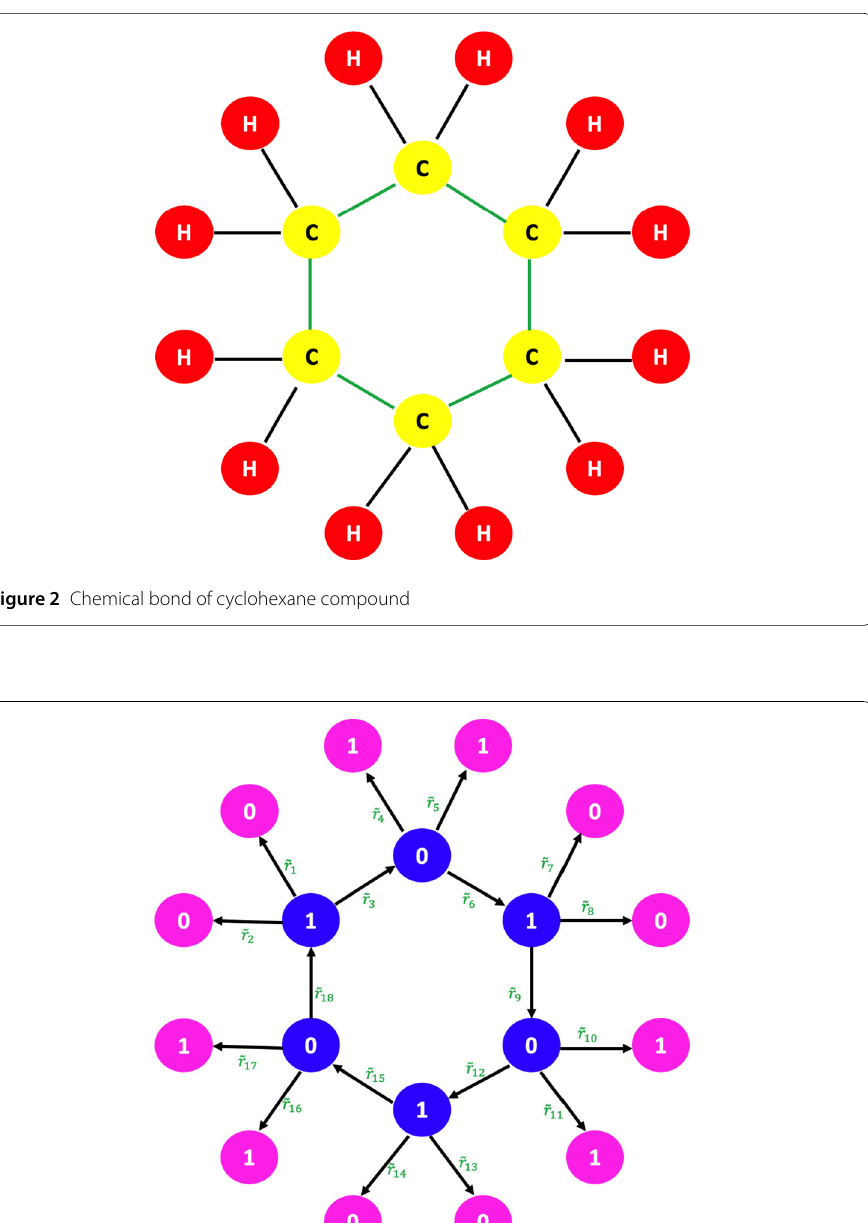
H × R × R × R → R is a given continuously differentiable function for (cid:3) = (cid:3) : [0,1]